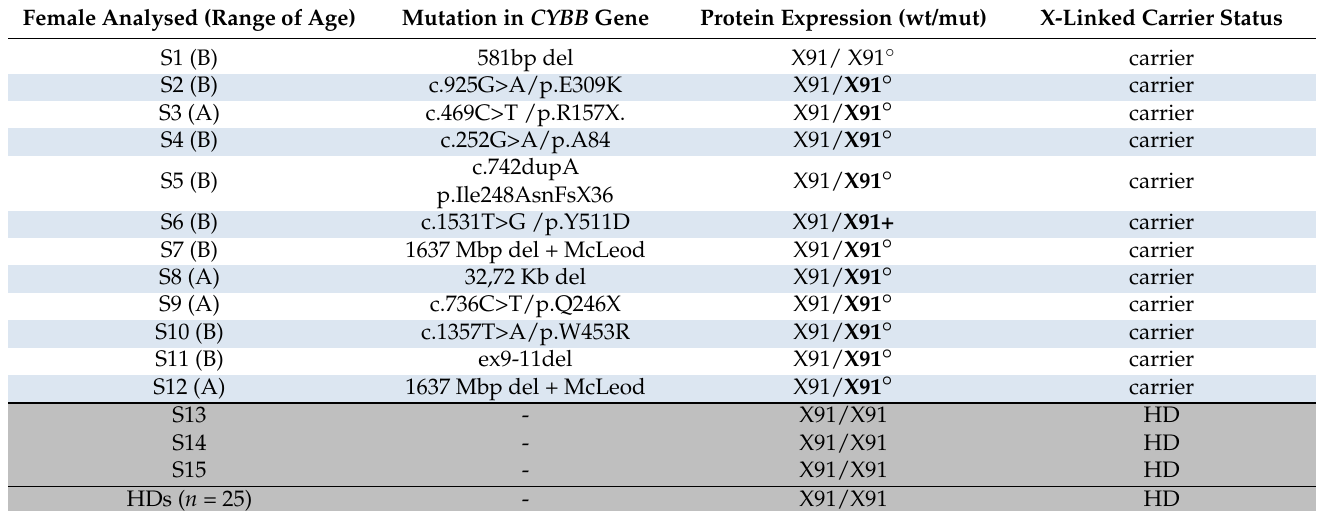
Table 1. Molecular Diagnosis of X-CGD carrier or HD status. Molecular and protein analysis revealed 12 X-CGD carriers (S1–S12) and 3 healthy